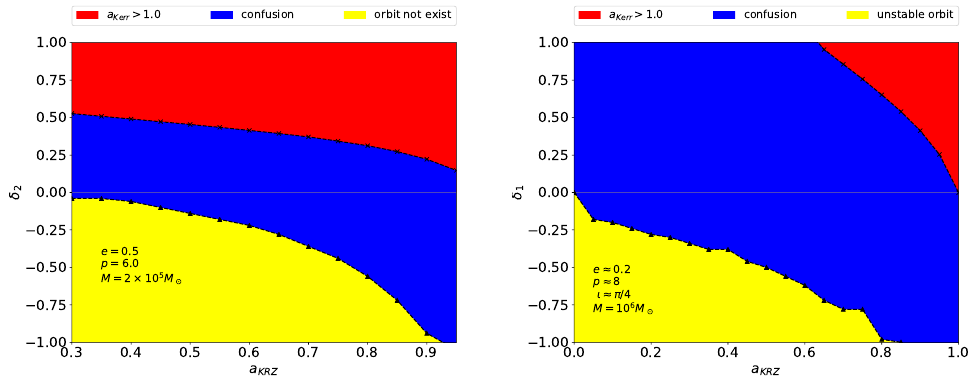
Figure 1. Upper and lower limits of δ i , whose signals can be confused with Kerr waveform, on the δ i - a KRZ parameter plane, set by equatorial orbit requiring a Kerr < 1 and stable orbit. Other parameters are shown on the figure. Waveforms in the red parameter region, when trying to equate orbital frequencies by varying ( M , a ) , have results in a Kerr larger than 1. Waveforms in the blue region can be confused with Kerr waveform. Orbits in the yellow region do not exist. Left panel: for equatorial orbit. Right panel: for inclined